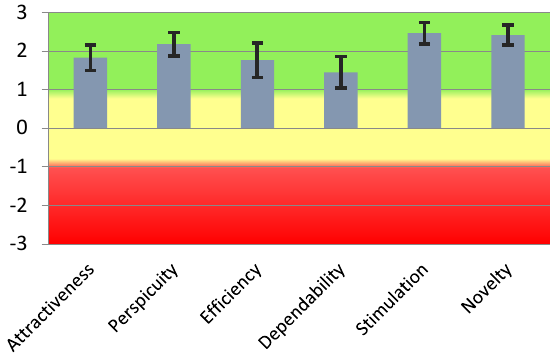
Figure 4. User Experience Questionnaire results. The evaluation of SONIS placed the user experience in the top 10% of previously tested products.